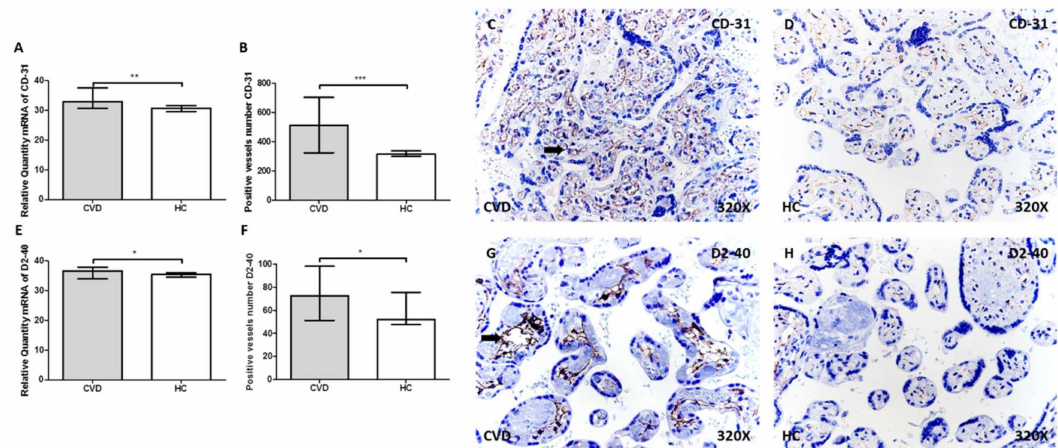
Figure 1. A–B. mRNA expression levels by RT-qPCR and positive vessels number for CD-31. C–D. Images showing the immunostaining for CD-31 in the placental villi for CVD (C) and HC (D) by immunohistochemistry. E–F. mRNA expression levels by RT-qPCR and positive vessels number for D2-40. G–H. Images showing the immunostaining for D2-40 in the placental villi for CVD (G) and HC (H) by immunohistochemistry. CVD = pregnancy-associated lower extremity chronic venous disease. HC = healthy controls with no history of CVD. p < 0.05 (*), p < 0.01 (**), and p < 0.001 (***). Arrow = positive protein